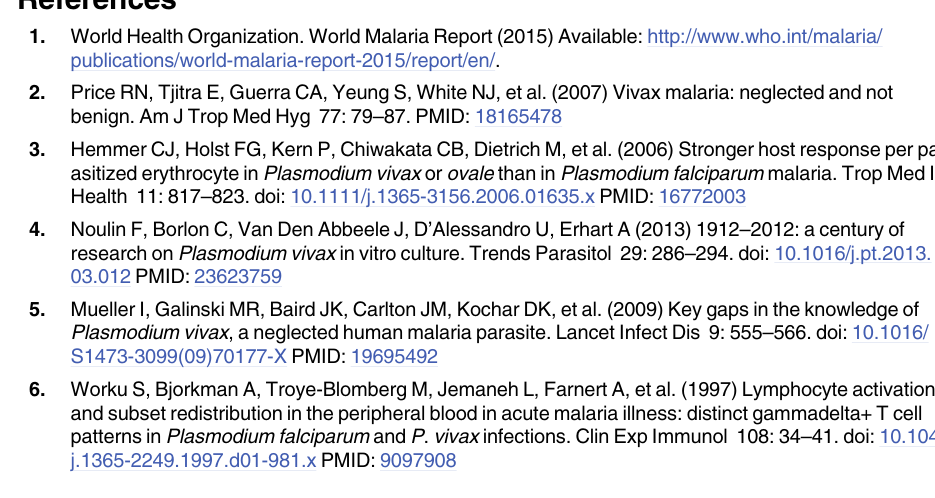
S1 Table. Demographics of P . falciparum and P . vivax infected volunteers S2 Table. Adverse events that occurred in P . falciparum and P . vivax infected